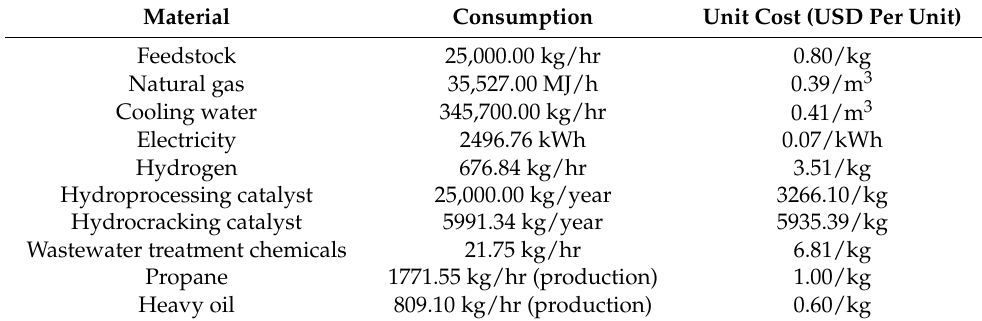
Table 4. Variable operating cost of a hydrotreating facility with a capacity of 600 tons/day